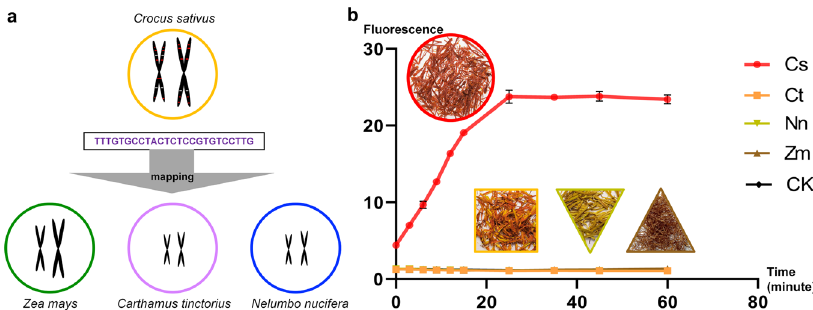
Fig. 4 Identi fi cation of Crocus sativus with GAGE. a Selection of target sequences. The red lines represented Cs_target1 and its copies and white lines represented the sequences within three base mismatches compared to Cs_target1. b Results of the identi fi cation of Cr. sativus with GAGE. The plant materials in the circle, square, triangle, and inverse triangle are the stigma of saffron, the fl ower of saf fl ower, the stamen of lotus, and the style and stigma of corn, respectively. The DNA substrates of each group were as follows: Cs: ITS2 fragments of Cr. sativus ; Ct: ITS2 fragments of Ca. tinctorius ; Nn: ITS2 fragments of N. nucifera ; Zm: ITS2 fragments of Z. mays and CK (negative control): nuclease-free water. All plots data represent means + / − standard deviation (SD) from three independent replicates.